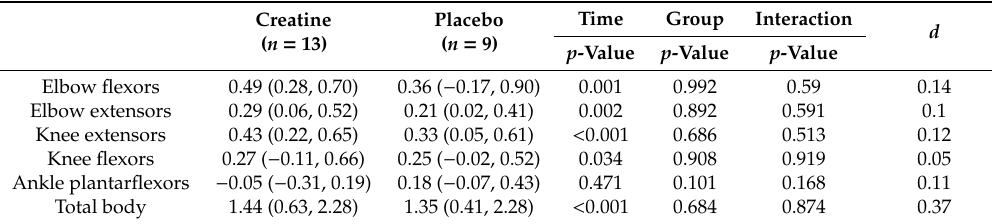
Table 3. Mean absolute changes (95% confidence intervals) from baseline to six weeks for muscle thickness (cm).